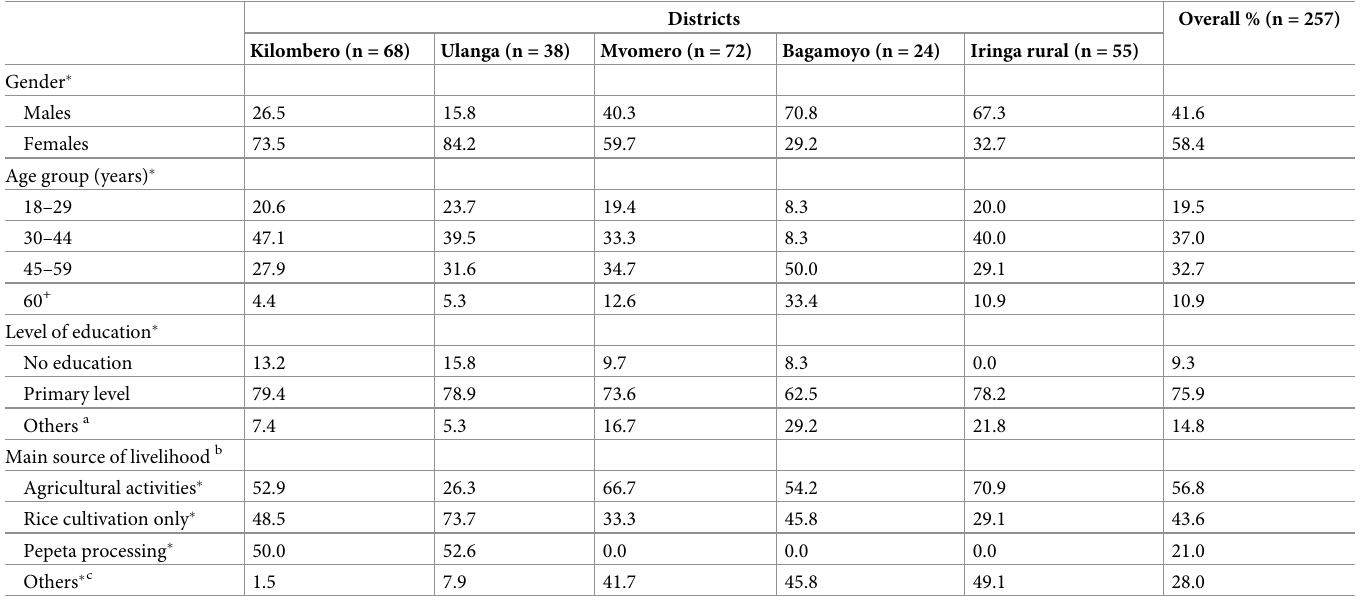
Table 2. Demographic profile of respondents (as percentages) in the surveyed administrative districts for pepeta product and its indigenous processing knowledge in Tanzania.